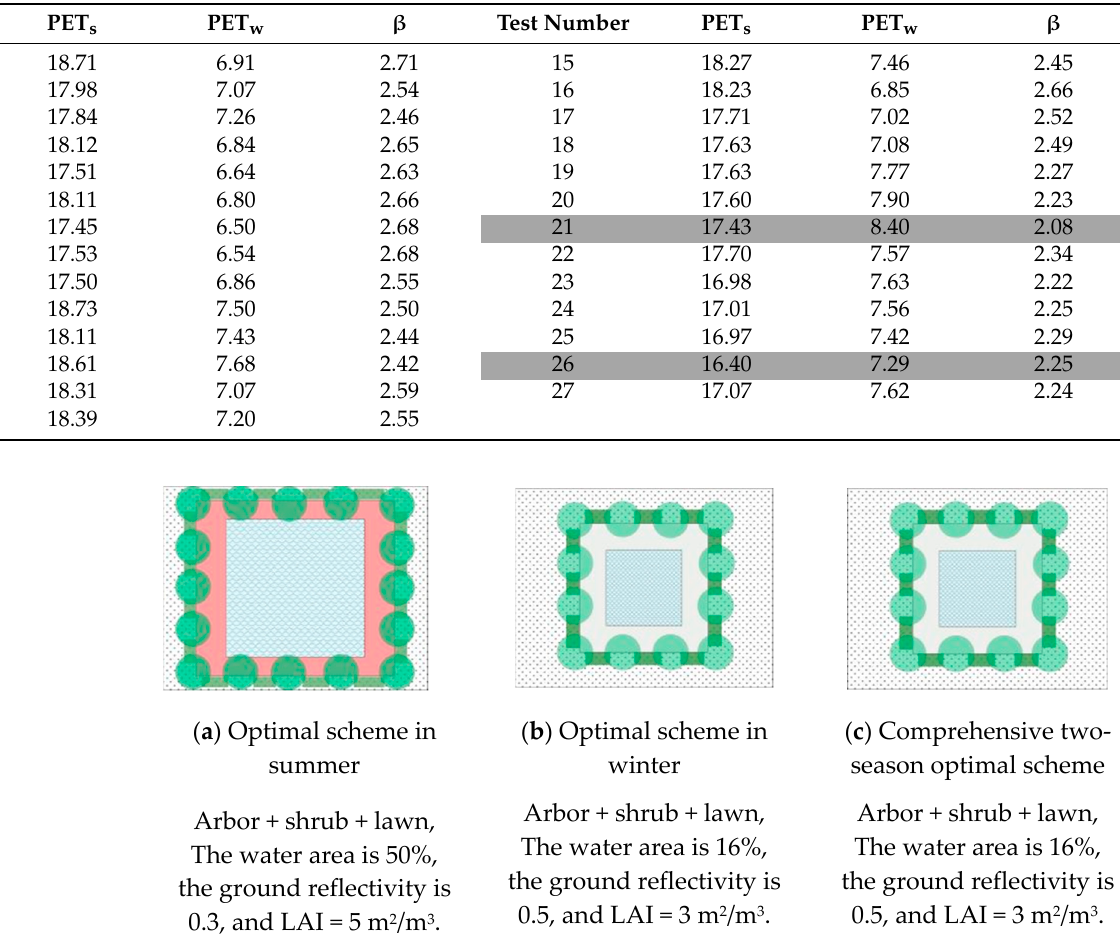
Figure 8. Plan diagram of optimization results of test scheme the tex.